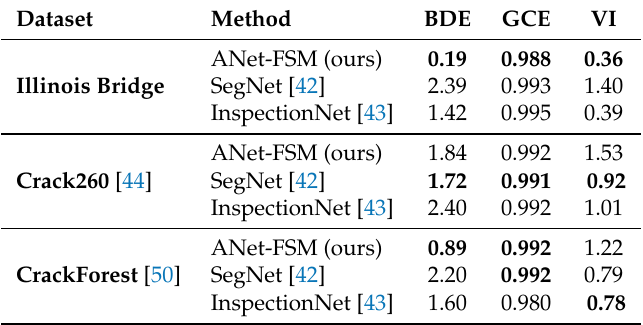
Table 7. Performance of crack identification in different dataset. The measures represented in this table are from Berkeley segmentation benchmark [53]. The lowest value of each measure represents the